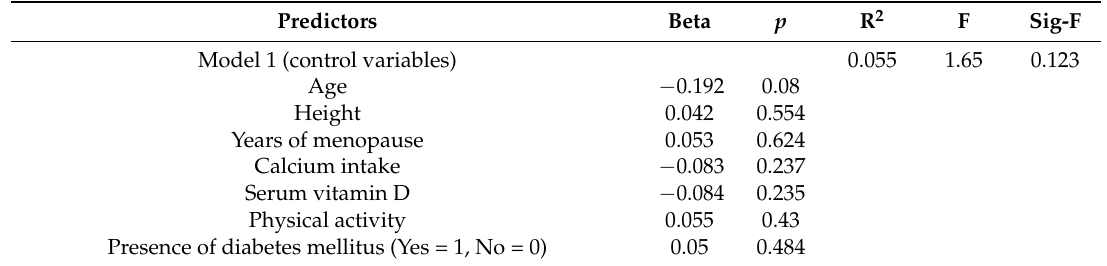
Table 4. Hierarchical regression analysis of factors predicting bone loss